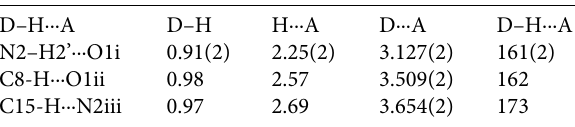
Table 3. Hydrogen-bond geometry in 6 and 7 (Å,